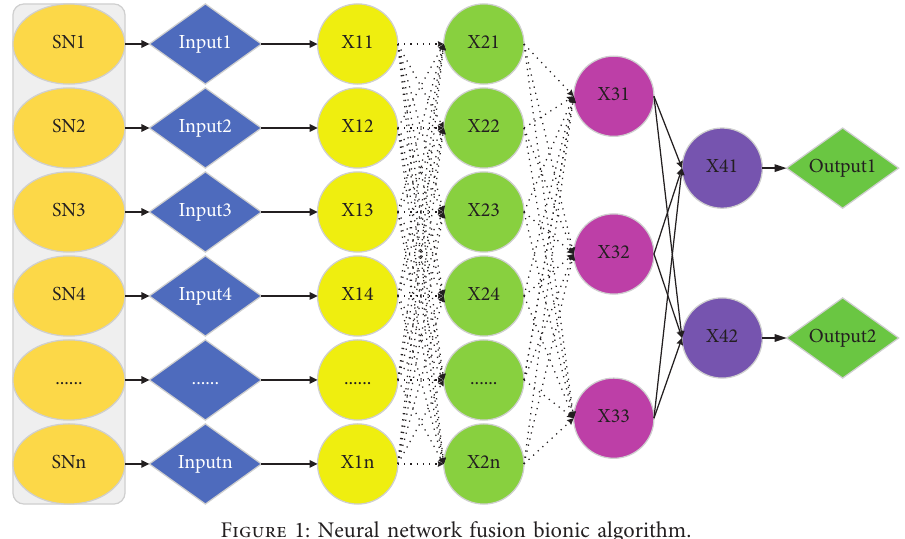
Figure 1: Neural network fusion bionic